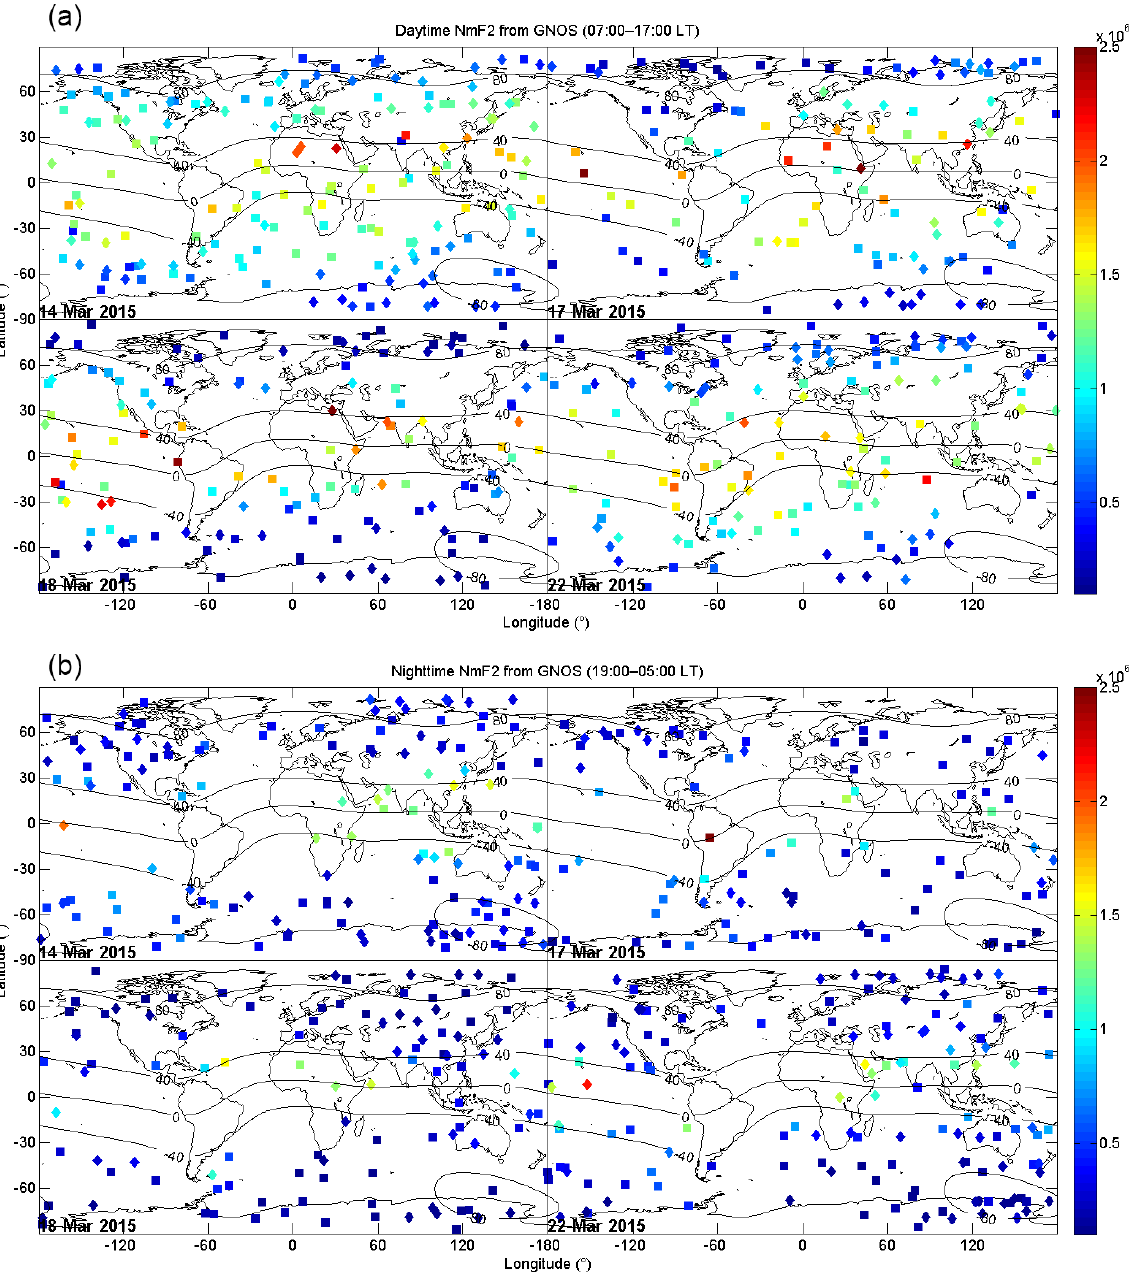
Figure 7. (a) NmF2 values detected by GNOS in all daytime (07:00–17:00LT) occultation events on typical representative days (14 March calm, 17 March magnetic storm main phase, 18 March rapid recovery phase, and 22 March steady recovery phase). Squares represent the geographic location of GNOS GPS occultation events. Diamonds represent the geographic location of GNOS BDS occultation events. The color of each square or diamond represents NmF2 magnitude for that occultation event. Black contours represent geomagnetic inclination isolines. (b) Same as (a) , but for the NmF2 values detected by GNOS in all nighttime (19:00–5:00LT) occultation